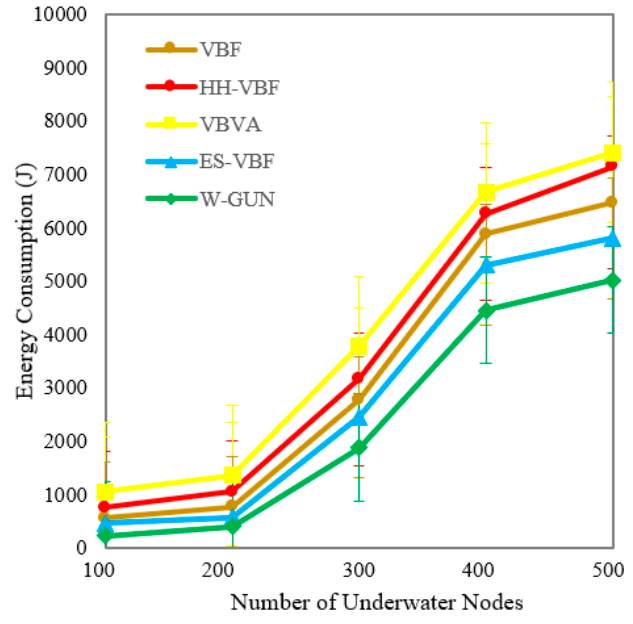
Figure 7. Energy consumption versus the number of underwater